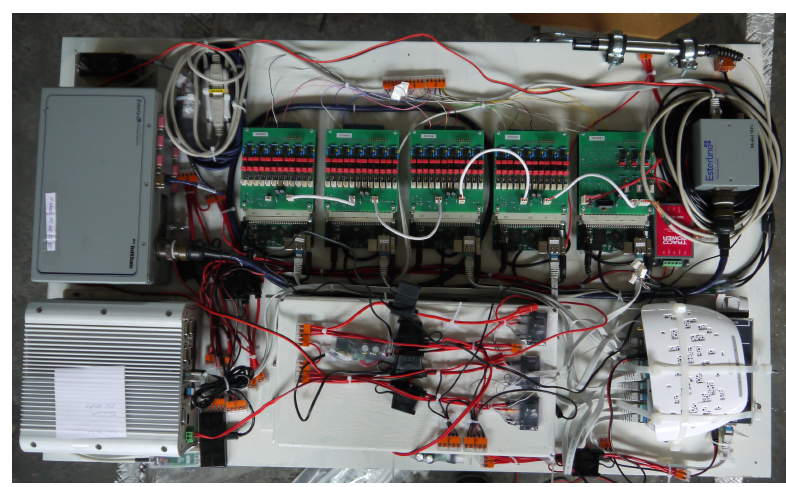
Figure 4. Data-acquisition system. Length, about 1